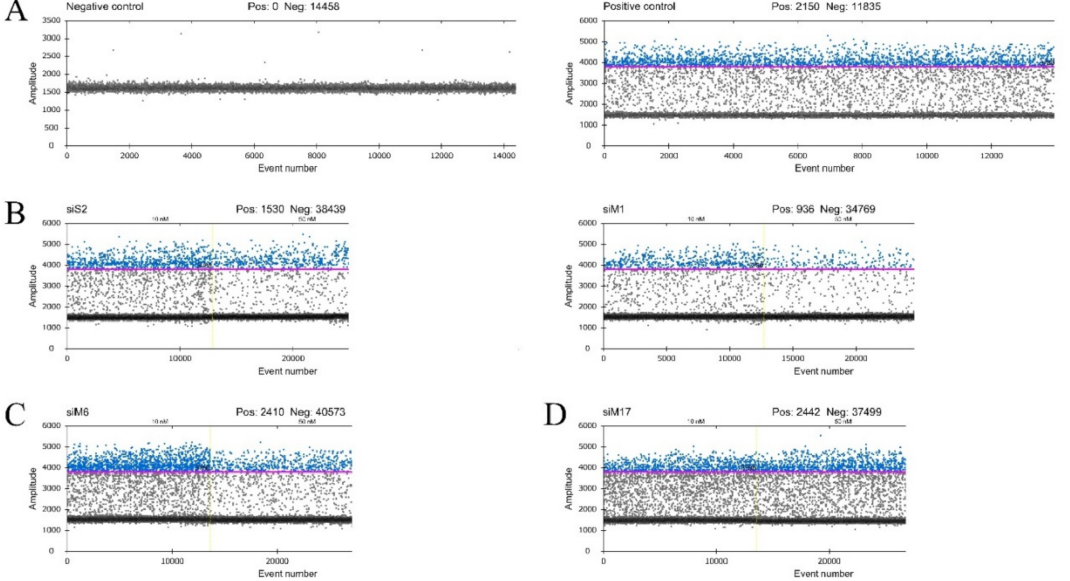
Figure 3. QuantaSofts’ RT-ddPCR fluorescent readouts. The horizontal axis represents the event number and the vertical axis represents the fluorescence amplitude in the FAM channel. The strict threshold line (pink line) was set for every sample at 3780 amplitude. Positive droplets were represented in blue and negative droplets were represented in grey. ( A ) The negative control sample was shown as the negative droplet population without positive droplets, the positive control sample was shown as the extensive positive droplet population; ( B ) siS2 and siM1, respectively, showed a concentration-dependent high inhibitory e ff ect, di ff erent concentrations (10 nM, 50 nM) were separated with a yellow, dotted line; ( C ) siM6 showed a concentration-dependent medium inhibitory e ff ect at di ff erent concentrations (10 nM, 50 nM) that were separated with a yellow, dotted line; ( D ) siM17 has shown low inhibitory e ff ect against CCHFV at di ff erent concentrations (10 nM, 50 nM) that were separated with a yellow, dotted